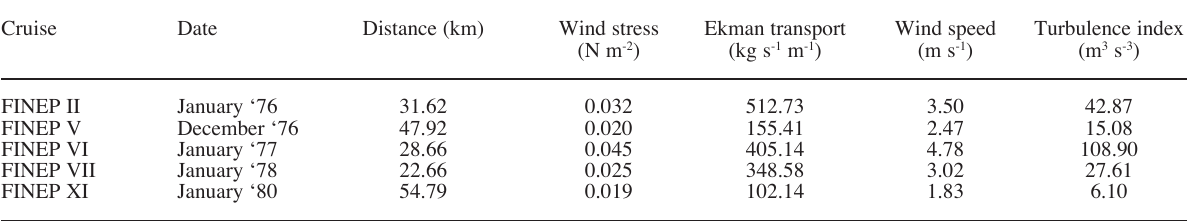
T ABLE 1. – Mean distance from the coast of the 18ºC bottom isotherm for each cruise, and average values of wind stress, wind speed, Ekman transport and turbulence index. Source: Project IOUSP/FINEP; Atlas of Surface Marine Data 1994; Da Silva et al.